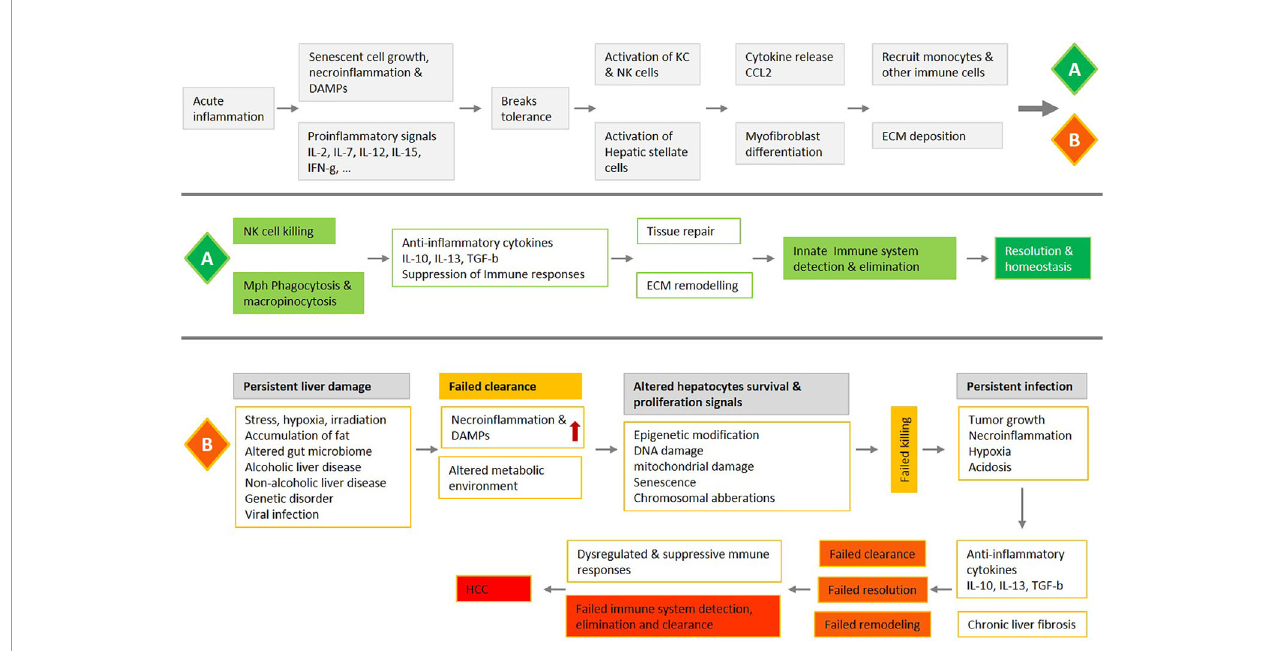
FIGURE 3 | An overview of liver acute in fl ammation and two possible processes, resolution (A) or chronic in fl ammation and HCC (B) , with a focus on the NK- macrophage kill and clearance. Liver acute in fl ammation must be resolved for homeostasis to be stored. An array of diverse mediators regulates NK cells and monocytes/macrophages traf fi cking and blunt production of in fl ammatory mediators, while also promoting clearance of tissue. Failure in NK cells killing, and macrophage clearance are associated with chronic unresolved in fl ammation, which is the central causative factor in the development of